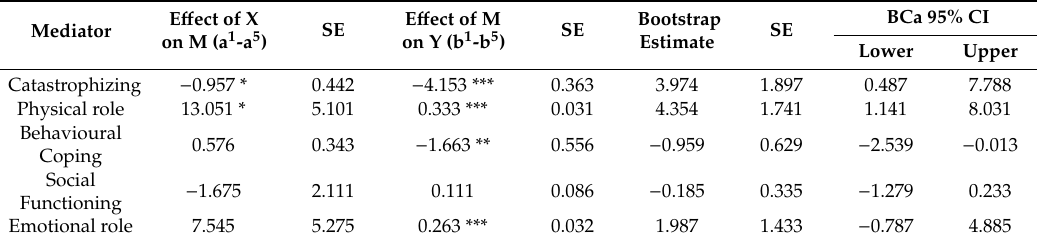
Table 3. Indirect e ff ect of non-participants / participants on bodily pain through catastrophizing, physical role, behavioural coping, social functioning and emotional